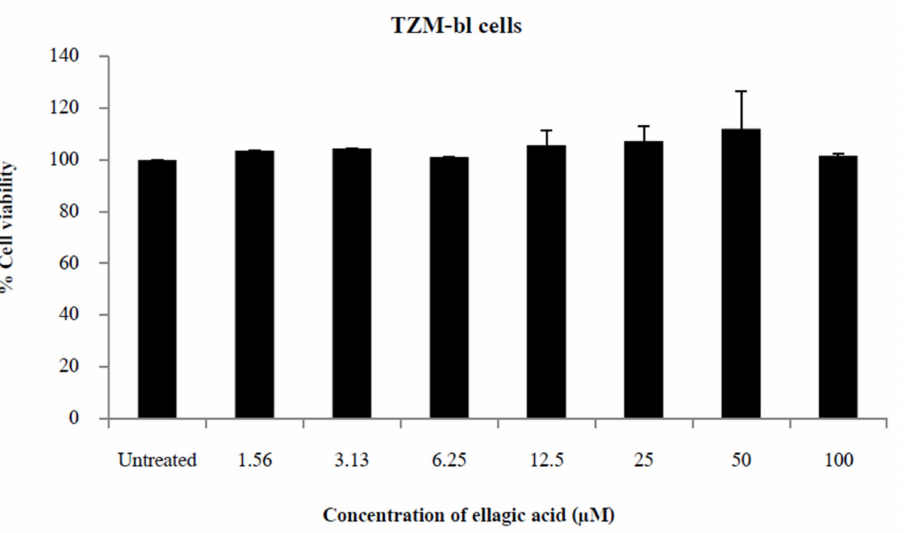
Figure 1. Ellagic acid cytotoxicity. Percent viability of TZM-bl cells 48 h after exposure to 1.56 to 100 µ M of ellagic acid. Percent viability was measured by CellTiter-Blue assay, which used the metabolic activity of cells as a proxy for viability. Percent cell viability was calculated as: [(ODtreatedcells − ODtreatedblank)/(ODcontrolcells − ODcontrolblank)] × 100. Bars show the mean + SD of three independent